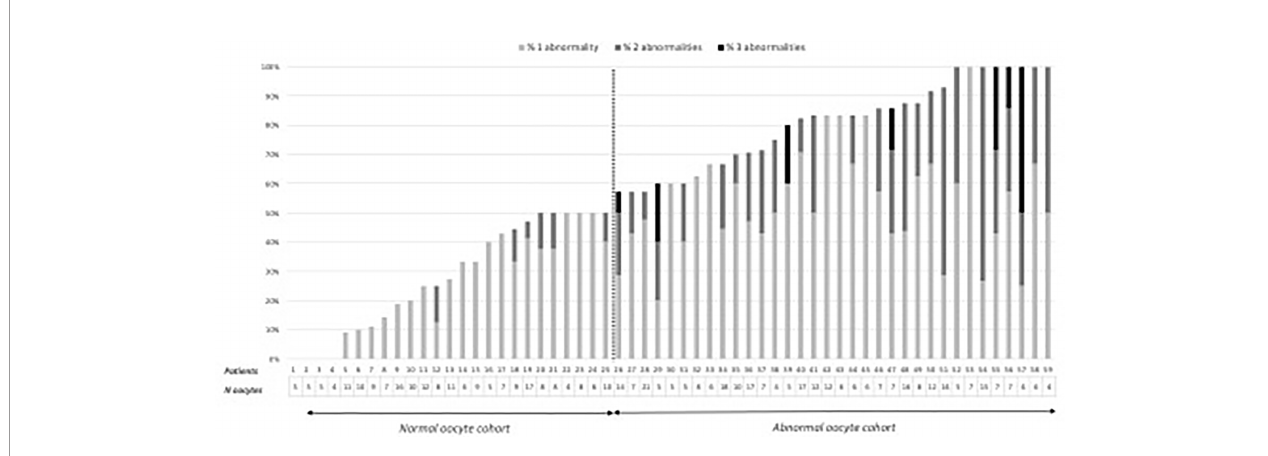
FIGURE 1 | Distribution of the number of oocytes and oocyte abnormalities by patient in the